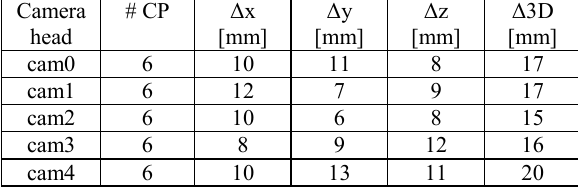
Table 3. RMSE values of study 1 for check point residuals between image-based georeferencing and tachymetry